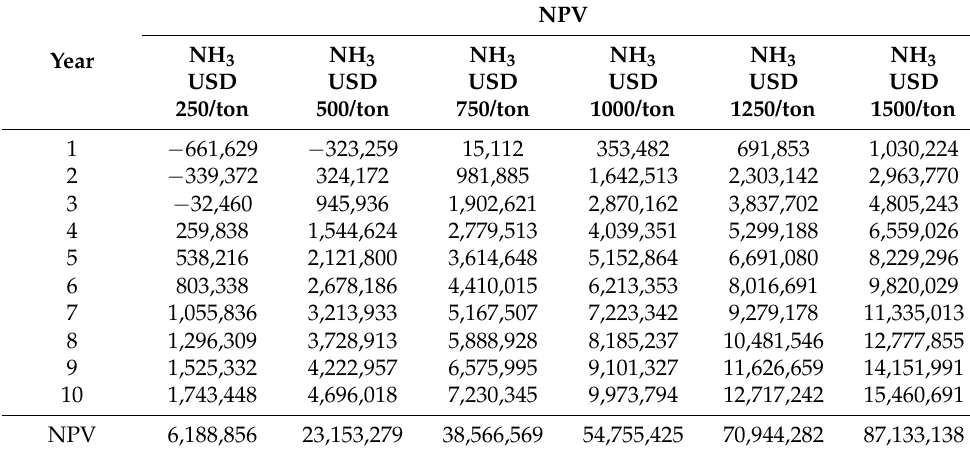
Table 13. Annual profit and NPV (the re-liquefaction system: USD 1